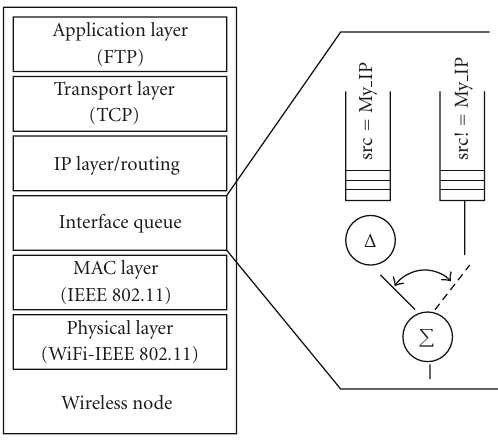
Figure 4: Structure of a IEEE 802.11 enabled